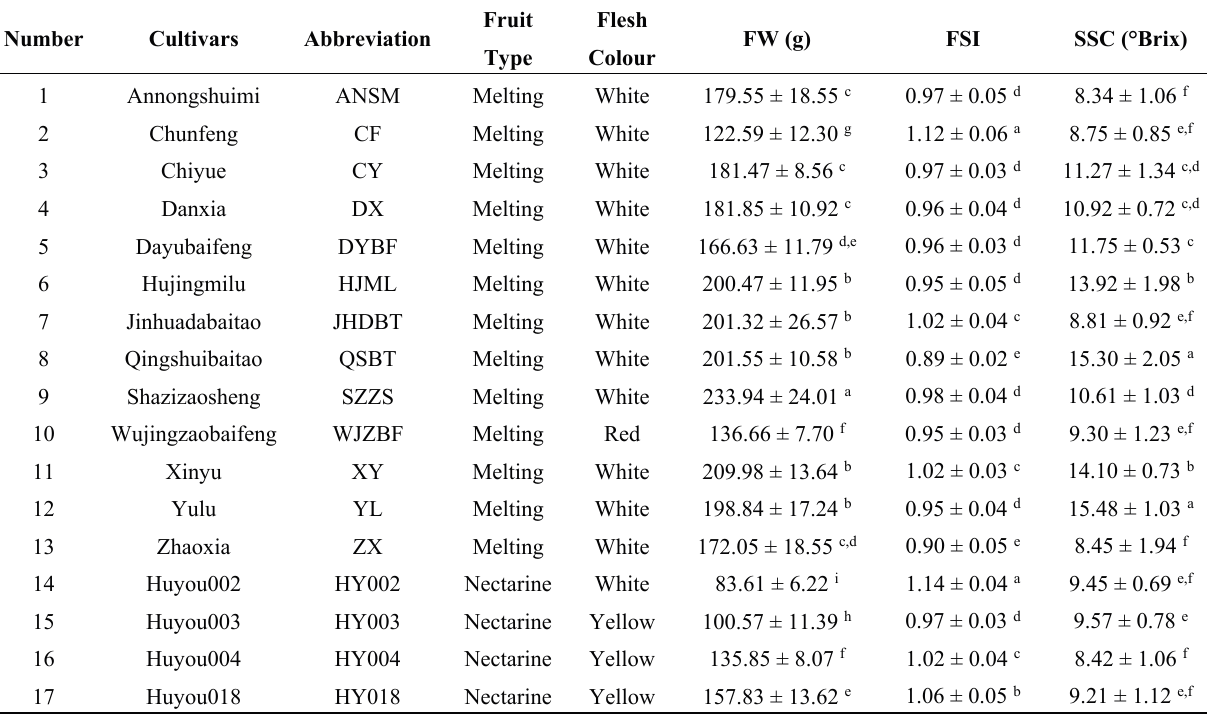
Abbreviations: FW, fresh weight; FSI, fruit shape index; SSC, soluble solid content; Data were expressed